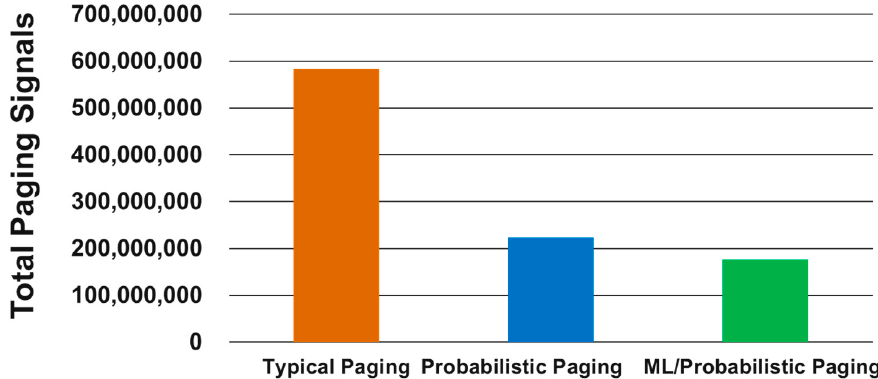
Figure 12. Total paging signals observed for different conditions of paging system.